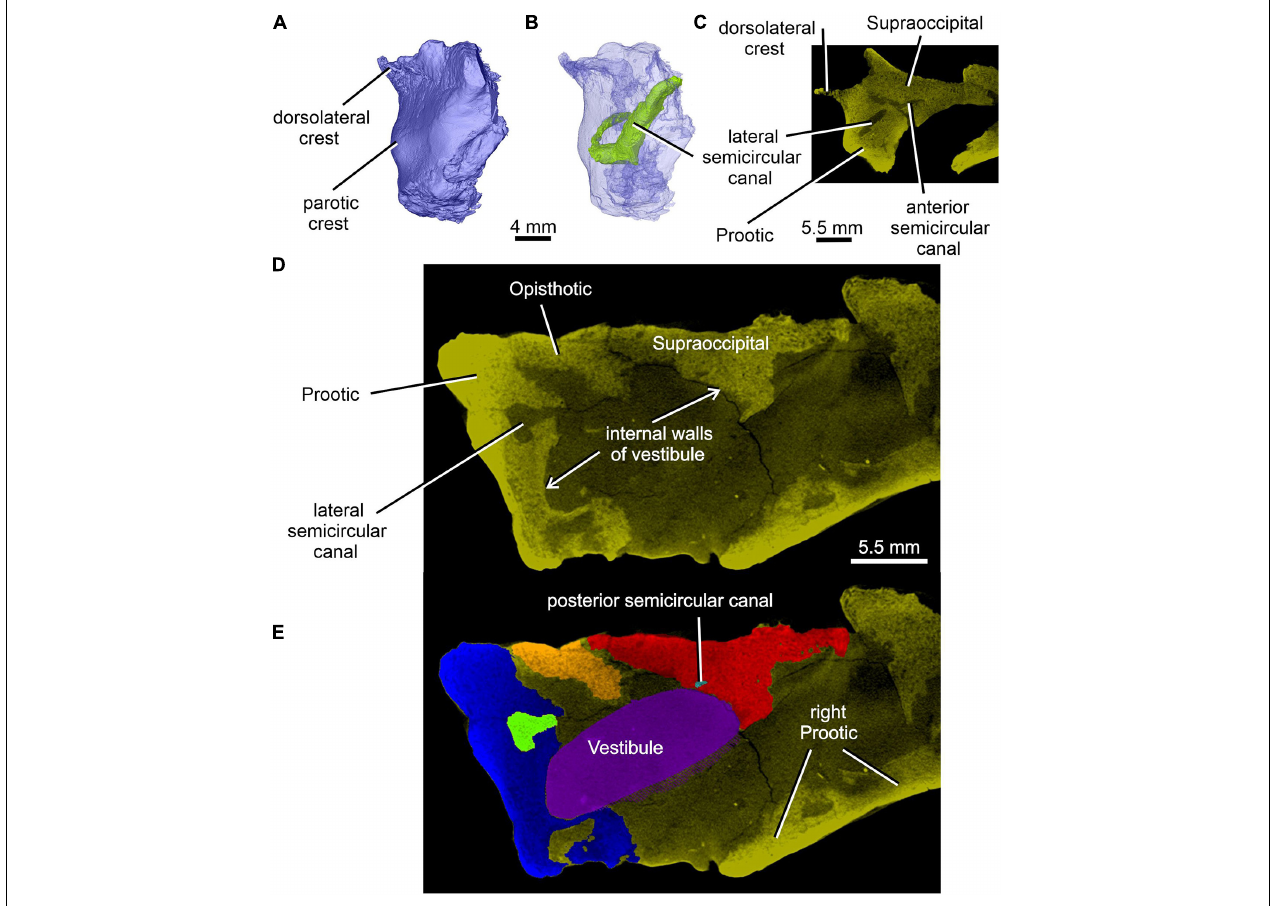
FIGURE 8 | Limnoscelis dynatis , CM 47653. (A,B) Left prootic in posterolateral view; (B) semitransparent. (C) Transverse CT section through the left prootic-left supraoccipital in the place of the junction of anterior and lateral semicircular canals. (D,E) Transverse CT sections through the walls of vestibule (D) and reconstructed vestibule (E) at the level of the medial opening of the lateral semicircular